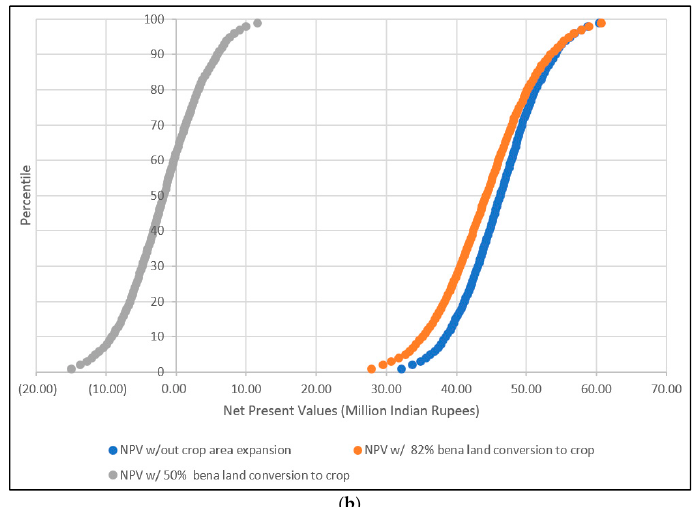
Figure 3. Net present value distributions of the lift irrigation project under alternative water use increase and land-conversion scenarios (generated from 5000 runs each); ( a ) increase in water con- sumption (50%, 75%, and 100%) with no change in crop area: NPVs for 75% and 100% water in- creases were positive in 100% of the simulation runs; and ( b ) bena land conversion (0%, 50%, and 82%) and increase in water consumption by 75%: NPVs with no crop area expansion and 82% bena land conversion were positive and almost identical in 100% of the simulation runs. The study results have several implications for the local-IWRM implementation. First, from an environmental point of view, the proposed restoration measures could en- hance water availability and attendant ecological benefits in the study region if the minor irrigation tanks are restored in a timely fashion. Increasing the stock of water through LIS remains within the overall natural hydrological limits of the region. However, without increasing the storage capacity of the existing tanks to capture LIS-generated additional water, the benefits of LIS may not fully realize. Second, from the point of efficiency, the economic viability of the local IWRM projects depends on several socio-economic factors and hydrological and other environmental characteristics of the area [66]. Based on the household survey, it was evident that as many as 82% of farmers were eager to expand their crop area when new water would become available. Our analysis shows that crop area expansion comes at high establishment costs and could compete for water with already-existing cropland. Using the incremental water (75% or more) on existing cropland could be just as profitable as the crop area expansion. The land conversion is a private decision, and those farmers who have private grassland may exercise their right to convert the same in response to increased water availability from the project. This could easily lead to the classic case of the “tragedy of the commons” [67] and put pressure on a publicly funded common water resource. Avoiding such prob- lems in the future would require suitable education, outreach, and regulatory measures for farmers so that crop area expansion is limited to low-water-intensive and least expen- sive crops. Third, from an equity point of view, only half of the farmers in the study area are